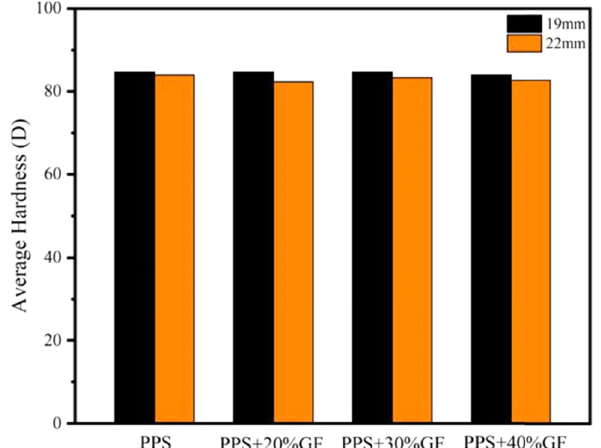
Figure 15: The hardness test results of polymer sleeve obtained from di ff erent polymer injection molding of spanner head.